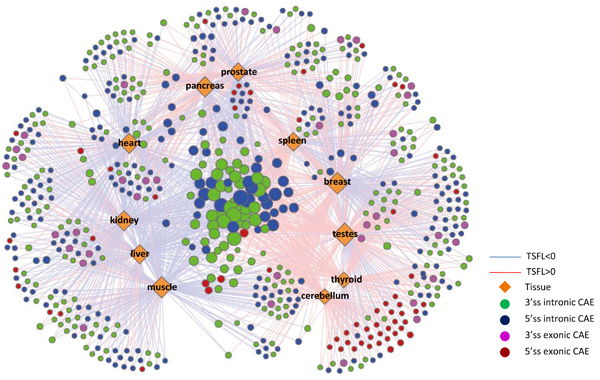
Tissue-specific splicing regulatory network. Yellow diamonds stand for tissues. The size of diamond is proportional to the degree of connections with cis-acting RNA elements (CAEs). Nodes with different colors indicate CAEs in different regulatory regions (see legends). Connections between CAEs and tissues suggest the regulatory relationships. Red and blue lines indicate TSFL > 0 and TSFL < 0, respectively. The size of circle is proportional to the number of tissues connected to CAE.